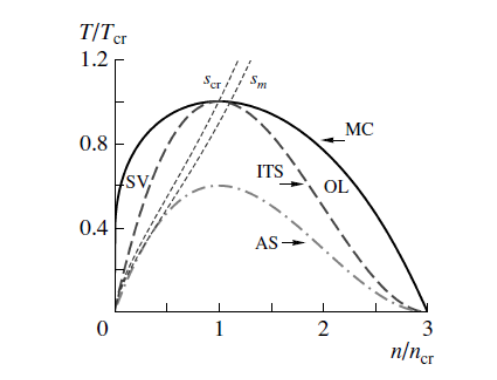
Figure 7. Figure from [31]. The phase diagram of the van der Waals EoS, T ( n ) -plane. The bold solid, dashed and dash-dotted curves demonstrate the boundaries of the MC, the spinodal region at T = const and ˜ s = const, respectively. The short dashed lines show adiabatic trajectories of the system evolution: the curve labeled s cr passes through the critical point; s m , through the maximum pressure point P ( n P , max ) on the P ( n )